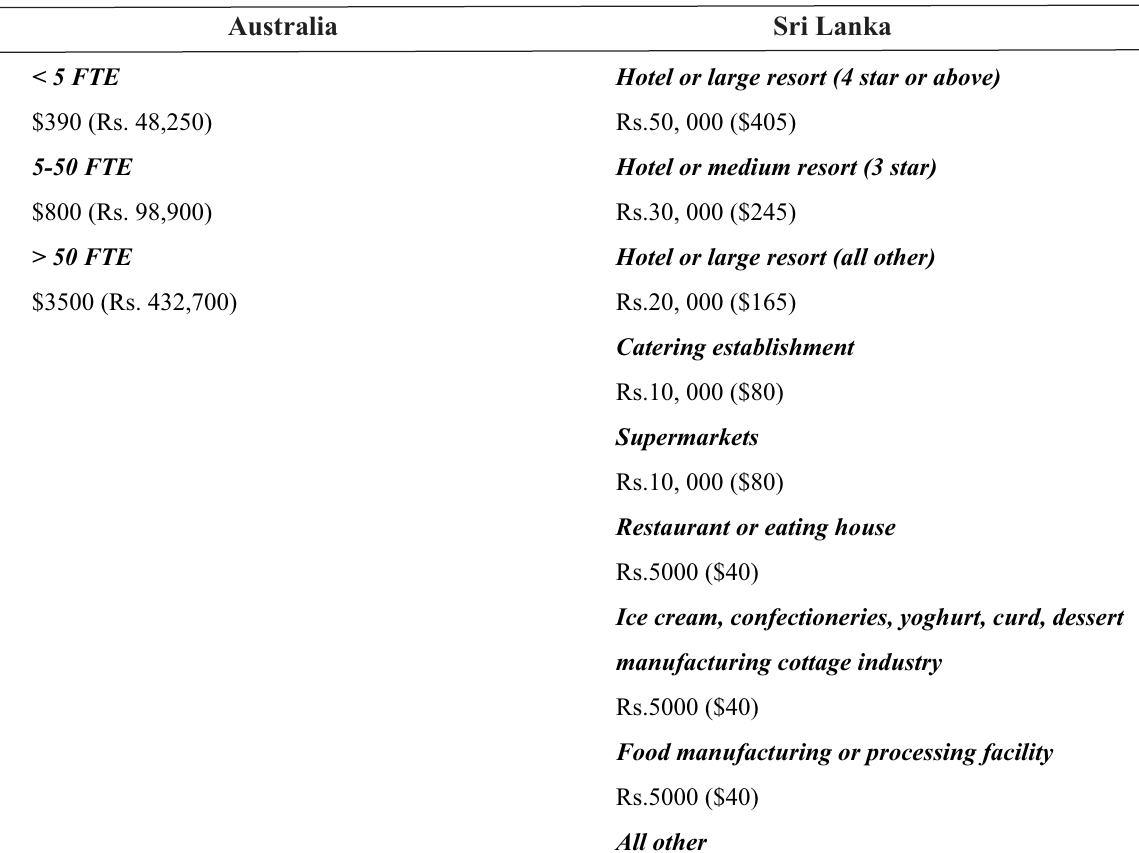
Table 5: Fees of